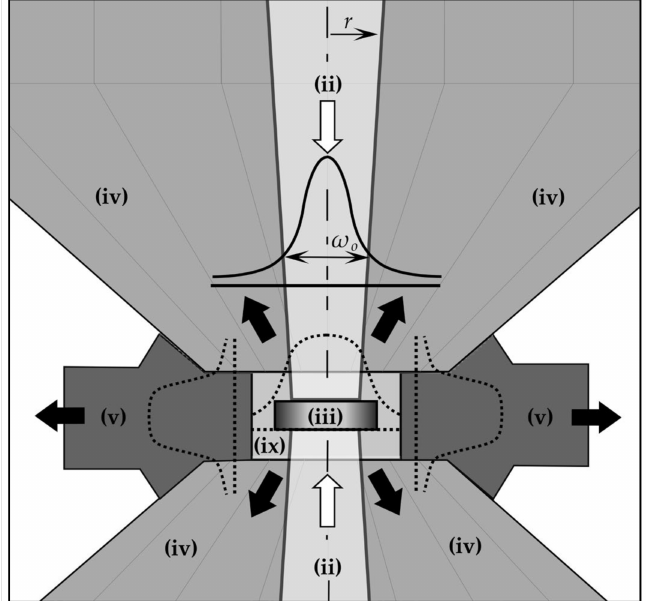
Figure 7. Schematic of Heat Transfer in an LH-DAC. With matched laser input from both sides (white arrows/beams), the resulting heat profile can be symmetric as shown (dotted graphs). Heat leaves primarily through the diamond anvils and secondarily through the gasket chamber (black arrows). Please see article text for component